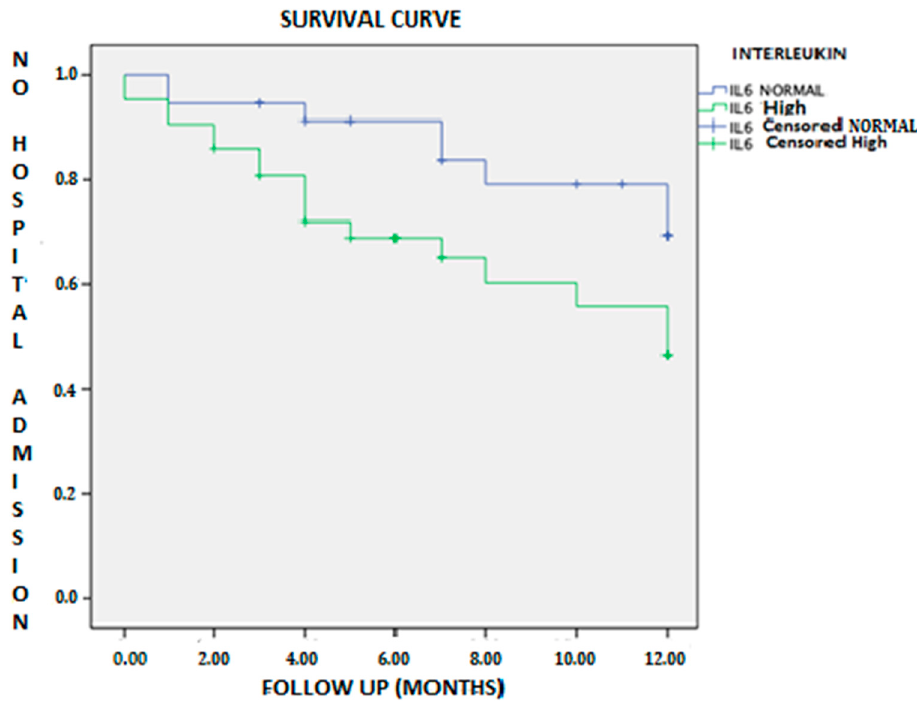
Figure 2. Kaplan–Meier survival curve of patients with heart failure and hospital admissions in both groups according to IL-6 level.